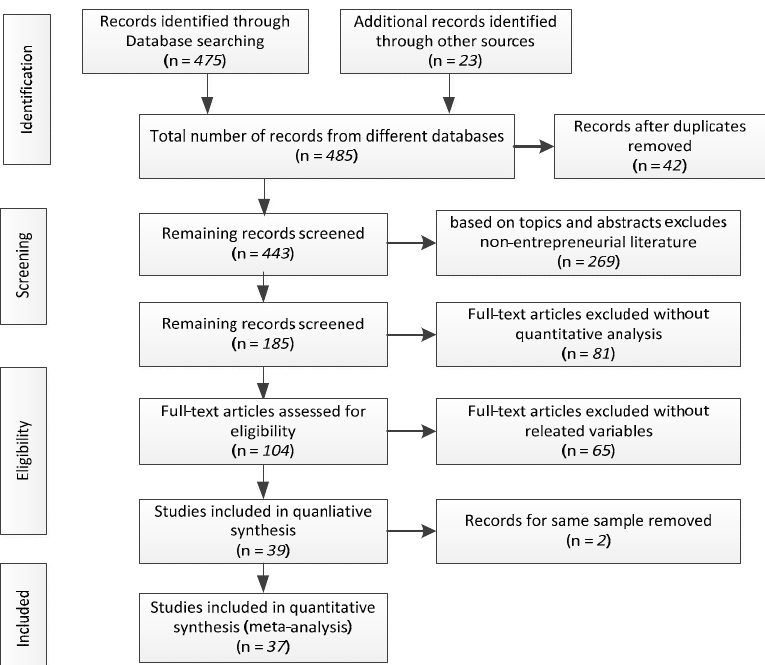
Figure 1. Flow diagram (article selection process).